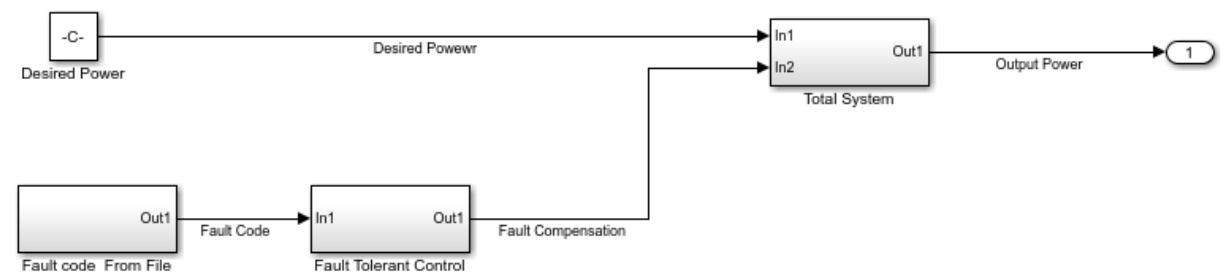
Figure 5. Fault tolerance and fault compensation process.